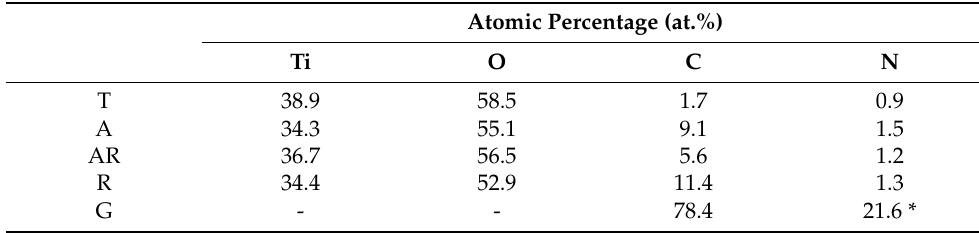
Table 3. Fibrinogen adsorption on different test specimens, measured by the presence of functional elements (Ti, O, C, and N) using